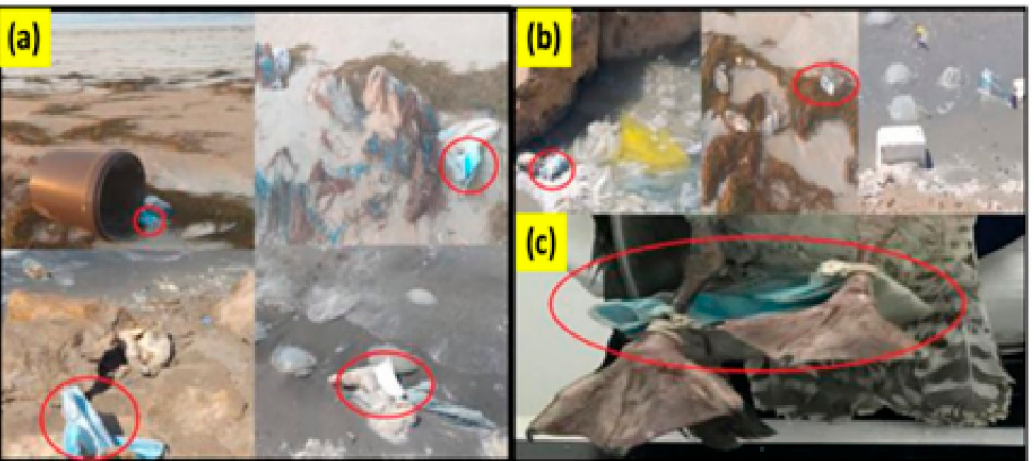
Figure 2. Adverse effects of COVID-19 PPE plastic pollution on marine and coastal ecosystems. ( a ) Face masks dotting a beach, ( b ) various plastic types found at a beach. ( c ) Seabirds’ feet tangled in face mask cords [57].